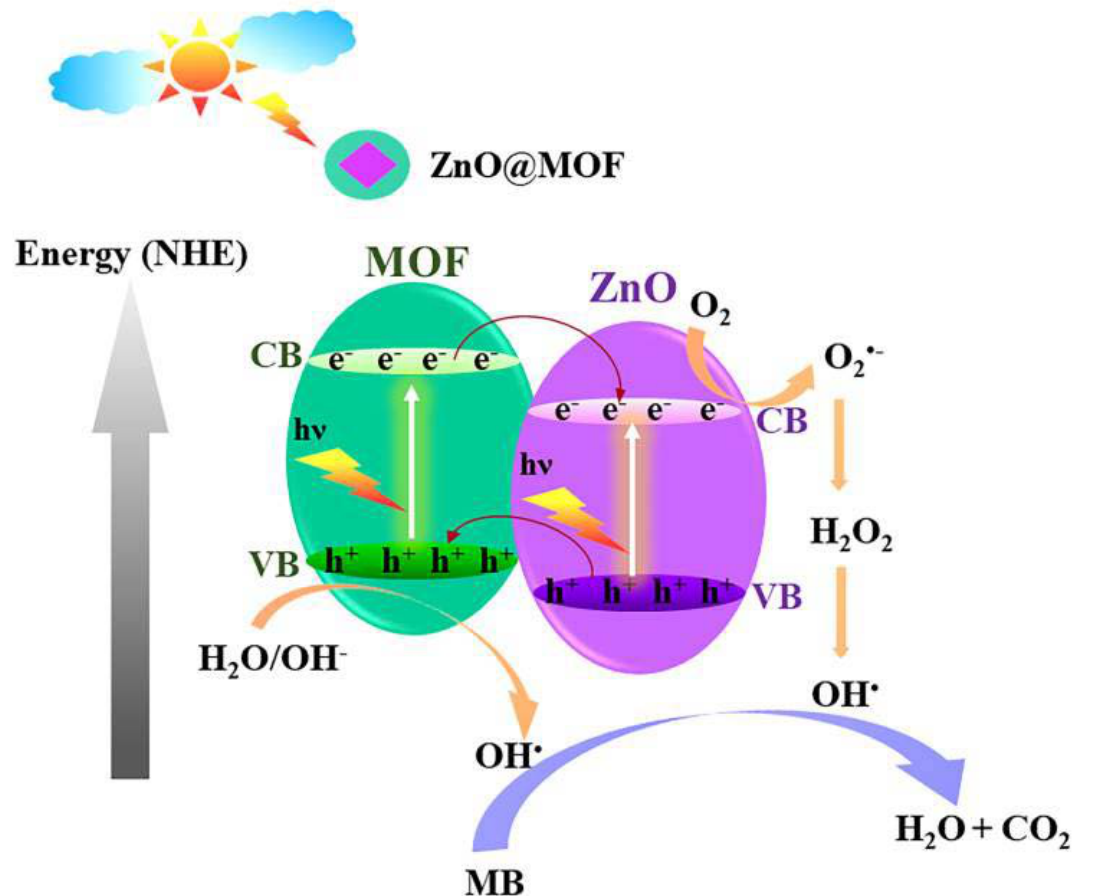
Figure 2. Photocatalytic mechanism of ZnO@MOF-46(Zn). Proposed reaction mechanism over ZnO@MOF-46(Zn) for photodegradation [82].